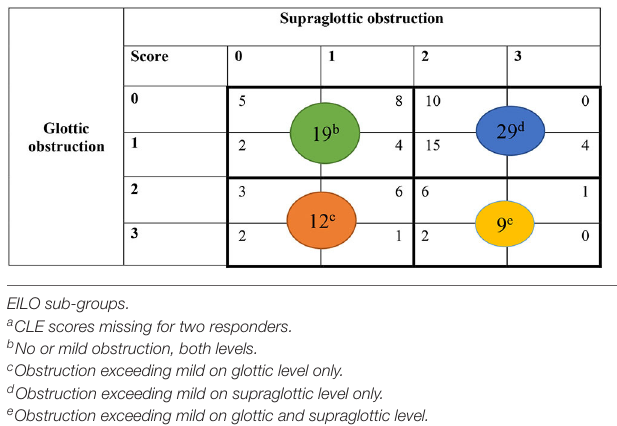
TABLE 2 | Sub-groups of 69 participants a with exercise induced laryngeal obstruction (EILO).